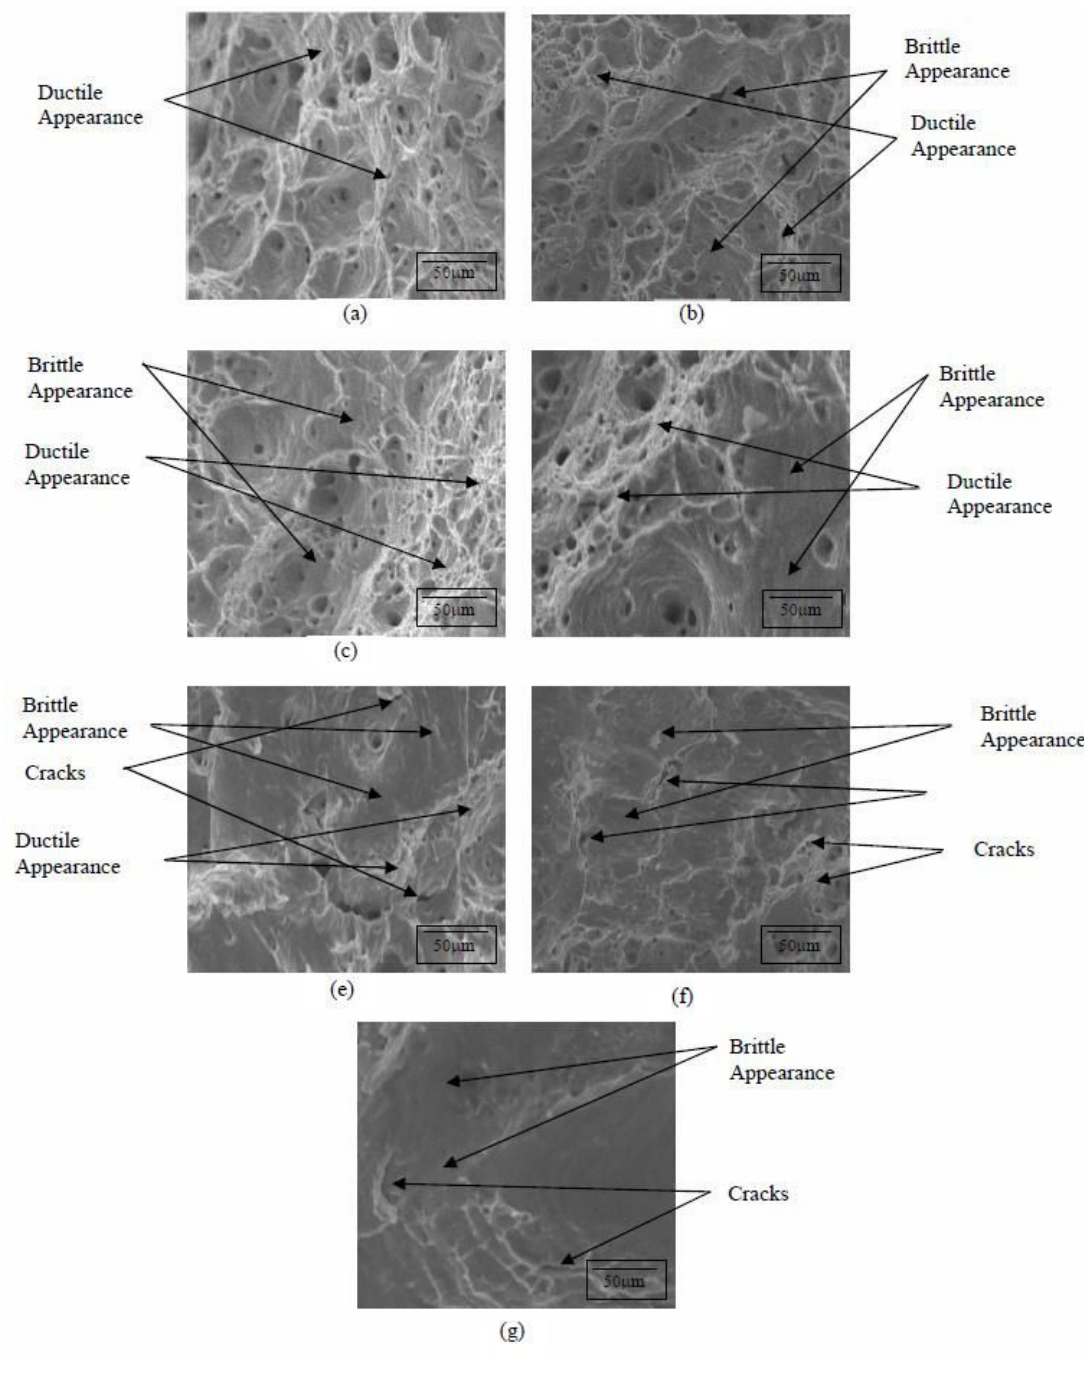
Figure 8. Fracture morphologies of the non-hydrogenated steel wire sample (a) and plasma-hydrogenated prestressing steel wire samples at various levels of: (b) 0%, (c) 30%, (d) 40%, (e) 50%, (f) 70% and (g) by increasing the prestressing procedure, which indicates clearly that the susceptibility of steel wire samples to the hydrogen embrittlement is enhanced by both hydrogenation and prestressing levels.